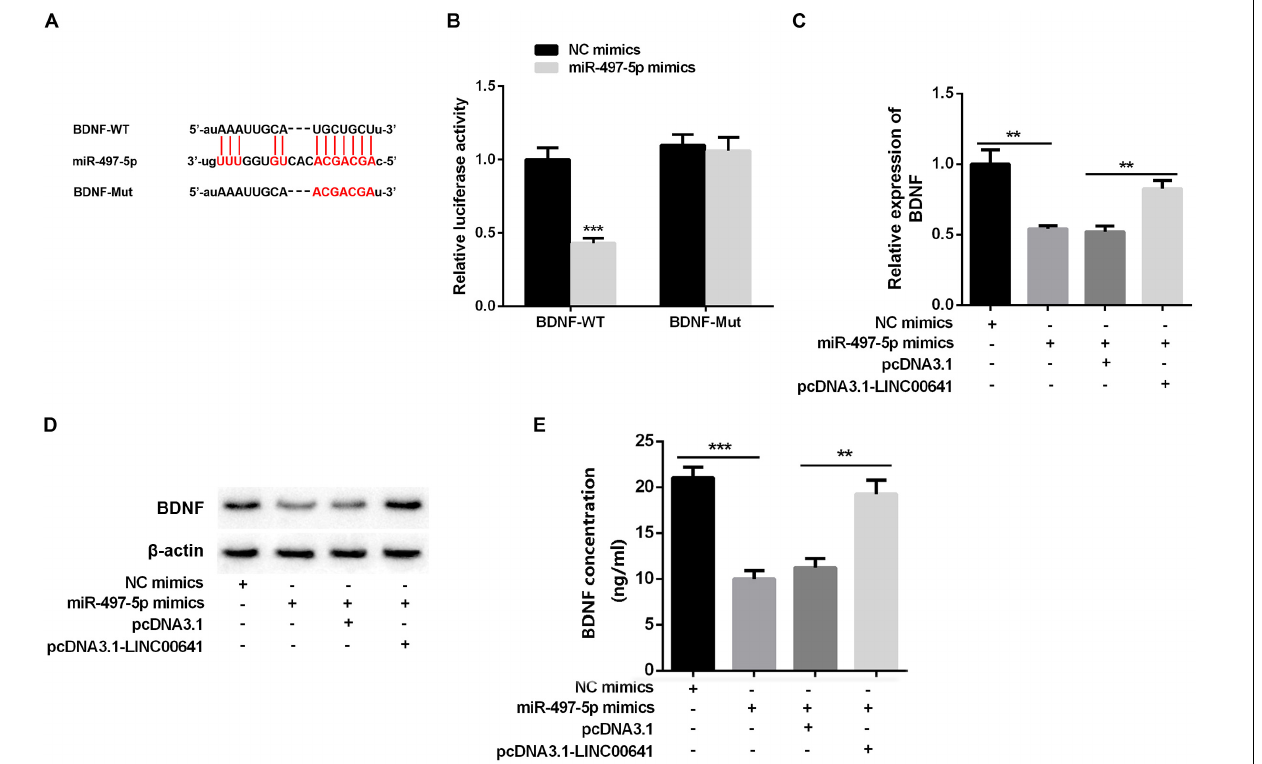
FIGURE 4 | BDNF was inhibited by miR-497-5p. (A) The binding sites of BDNF and miR-497-5p were predicted through Targetscan (http://www.targetscan.org/vert_72/). (B) Dual-luciferase reporter assay was adopted to validate the binding relationship of miR-497-5p on the 3 (cid:48) UTR sites of BDNF, *** P < 0.001 vs. NC mimic group. (C) qPCR was adopted to detect BDNF mRNA expression after overexpression of LINC00641 in miR-497-5p mimics cell line. (D) Western blot and (E) ELISA were employed to detect the protein expression of BDNF. ** P < 0.01 and *** P <